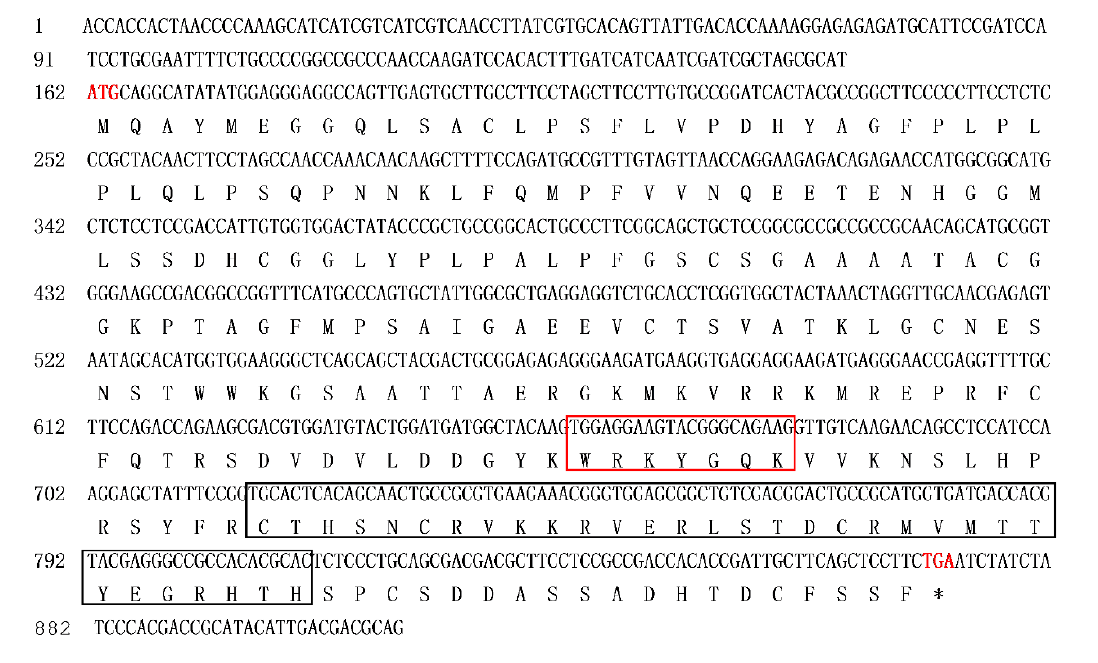
Figure 1. Nucleotide acid sequences and deduced amino acid sequences of the sugarcane ScWRKY3 gene obtained by PCR amplification. The sequence of the WRKY motif (WRKYGQK) is highlighted in the red box, and that of the C 2 H 2 domain (C X4 C X23 H X H) in the black box. The upstream sequences to start codon ATG (marked in red font) is 5 (cid:48) untranslated region (UTR) and the downstream sequences to stop codon TGA (marked in red font) is 3 (cid:48) UTR of ScWRKY3 . *: stop